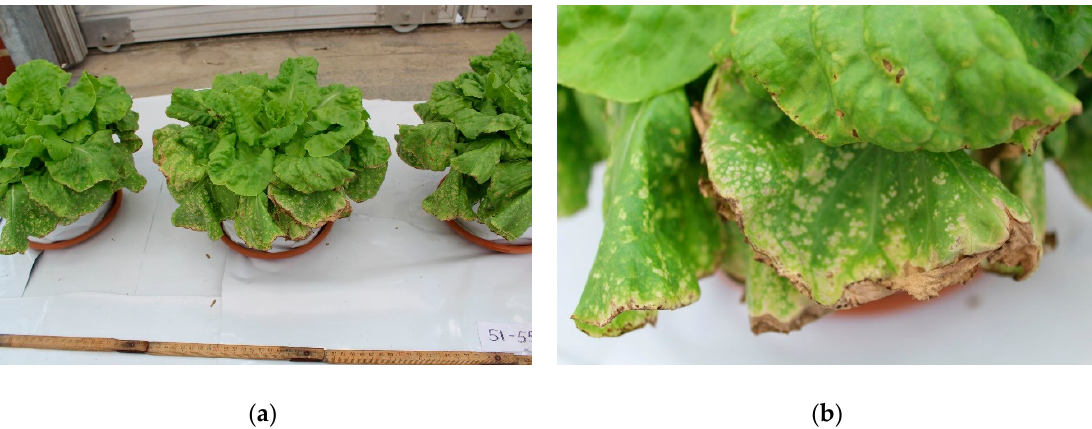
Figure A2. Lettuce shoots on day 13 ( a ) and day 37 ( b ) of the experiment. The inner and outer leaves were homogeneously green in color. Some of the lettuce shoots suffered from leaf tip necrosis (see also Figure A3) or drought stress, the latter indicated by light brown dry leaves.